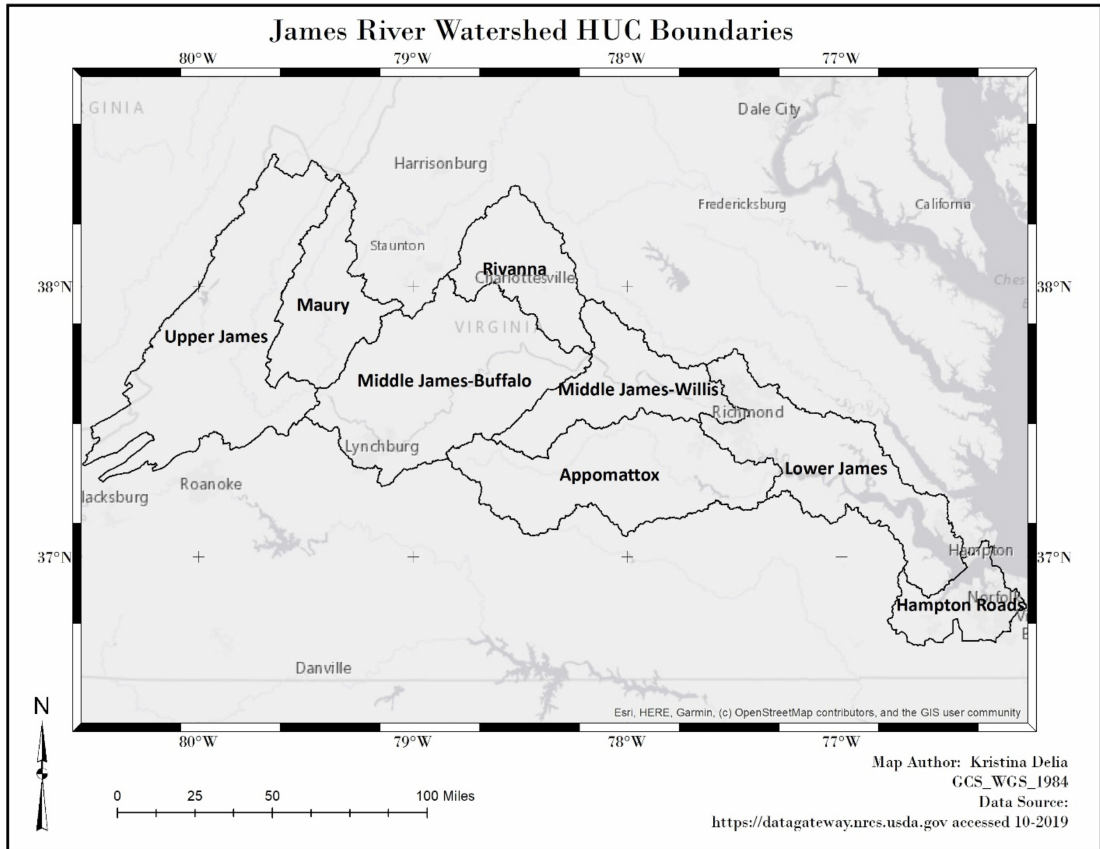
Figure 1. Map of Virginia showing the watershed boundaries of the James River watershed, including hydrologic unit codes